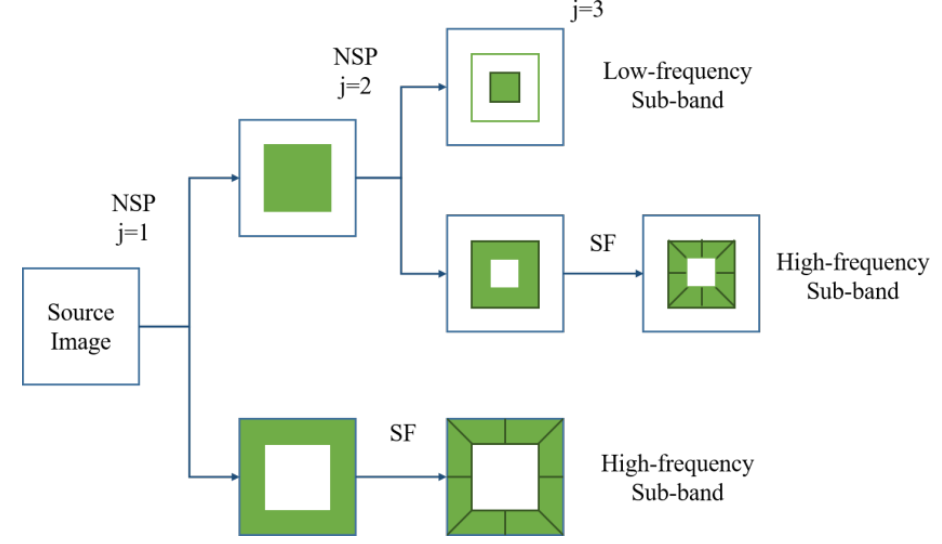
Figure 1. Three-level NSST decomposition of source image.